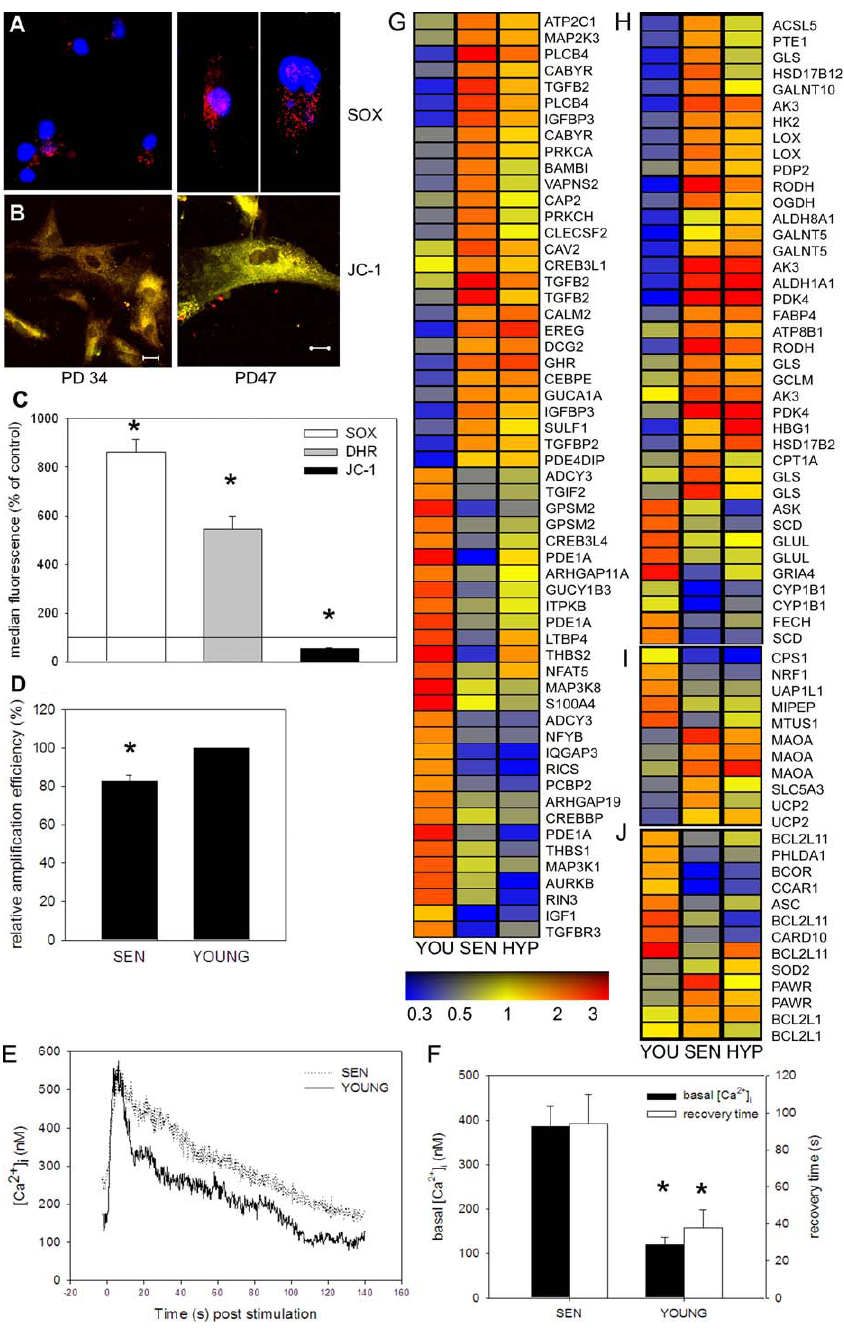
Figure 1. Mitochondrial Dysfunction and Retrograde Response in Senescent Cells (A) and (B) Confocal images of actively proliferating (PD 34) and senescent (PD 47) MRC-5 fibroblasts. (A) Red MitoSOX fluorescence indicates mitochondrial superoxide. Blue: DAPI. Note lower average red fluorescence and cell-to-cell heterogeneity in proliferating cultures. (B) JC-1 ratio images. A shift from red to green fluorescence indicates low MMP. (C) MitoSOX, DHR, and JC-1 ratio intensities in senescent MRC-5 fibroblasts as measured by FACS (percentage of young fibroblast control, set to 100%). Data are mean 6 s.e.m., n ¼ 3. An asterisk (*) indicates a significant difference to young controls with p , 0.001. (D) Integrity of mtDNA as measured by the relative amplification efficiency for an 11-kb mtDNA fragment in young and senescent MRC5 cells. Data are mean 6 s.e.m. An asterisk (*) indicates a significant difference to young controls with p , 0.001. (E) Single cell traces of cytoplasmic calcium levels [Ca 2 þ ] i following a challenge with 100 mM CaCl 2 as measured by Fluo3 fluorescence confocal imaging. (F) Basal cytoplasmic [Ca 2 þ ] i levels and recovery times in young and senescent cells. Data are mean 6 s.e.m. from 13 young and 8 senescent cells. An asterisk (*) indicates a significant difference between young and senescent cells with p , 0.001. (G–J) Relative mRNA expression levels in young (YOU), senescent (SEN), and hyperoxia-treated (HYP) MRC5 (averages of two [HYP] to four [YOU] independent experiments per condition). Fold-change colour code is indicated on the bottom. For some genes, the arrays contained probe sets resulting in multiple occurrences. All genes showing at least a 2-fold expression difference between YOU and SEN were selected if the expression difference was confirmed in HYP and if they fell into one of the following categories: (G) Ca-dependent signalling; (H) glycolysis and Krebs cycle; (I) mitochondrial function and biogenesis; and (J) stress response and apoptosis. doi:10.1371/journal.pbio.0050110.g001 PLoS Biology |